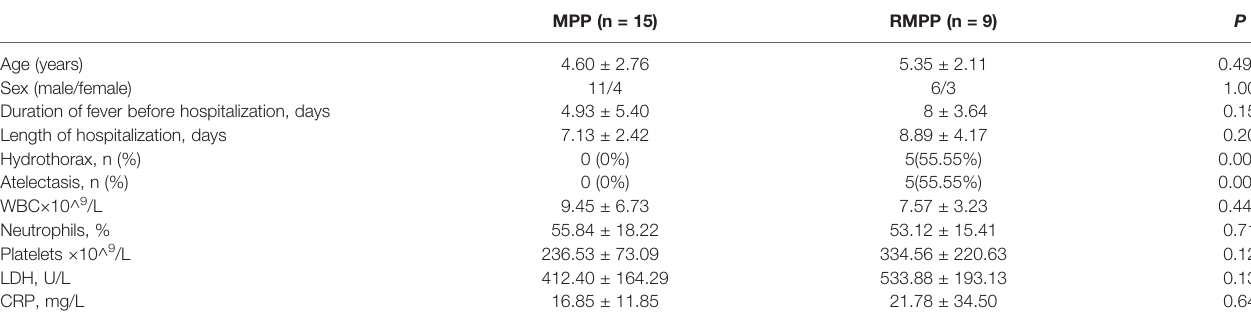
TABLE 1 | Clinical characteristics of children with